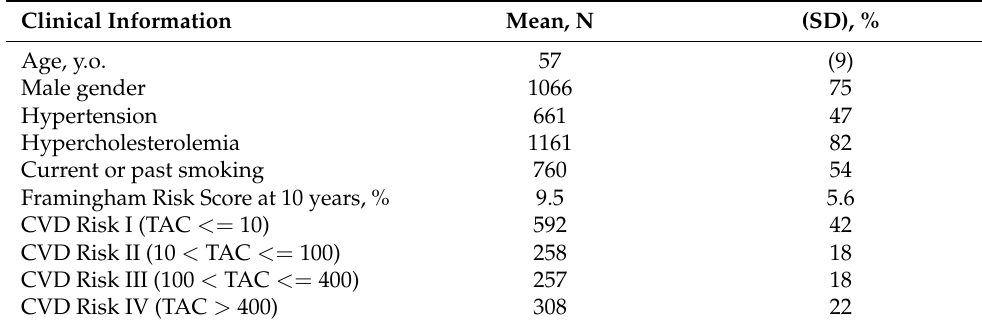
Table 1. Clinical information for the 1415 patients. More than 58% of the patients presented a TAC score greater than 10.